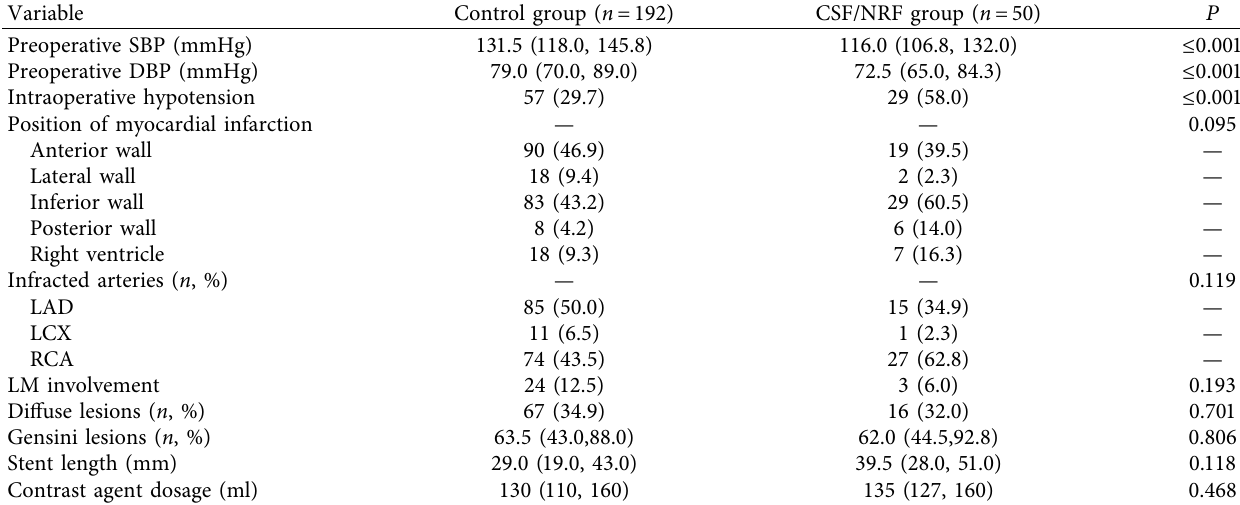
Table 2: Angiographic procedural characteristics of the study population, mean ± SD or n (%).